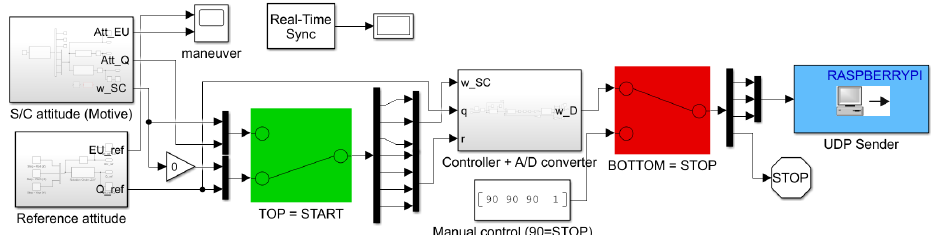
Figure 11. Simulink Desktop Real-Time model running on the PC workstation.